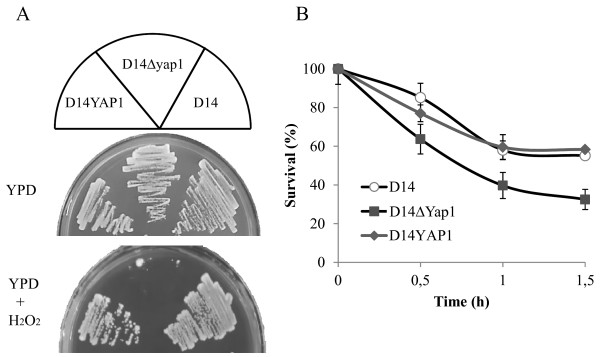
Implication of Yap1p transcription factor in human blood yeast survival. In panel A, the strain D14 and a YAP1 mutant were plated in YPD or YPD with 2.5 mM HO. In panel B, blood survival assay is shown for wild type D14 and YAP1 mutant strain. Yeasts were inoculated 1:1 ratio respect leucocytes and yeast survival was followed for 1.5 hours by plating in YPD agar plates. Data corresponds to average and standard errors of three independent biological replicates.